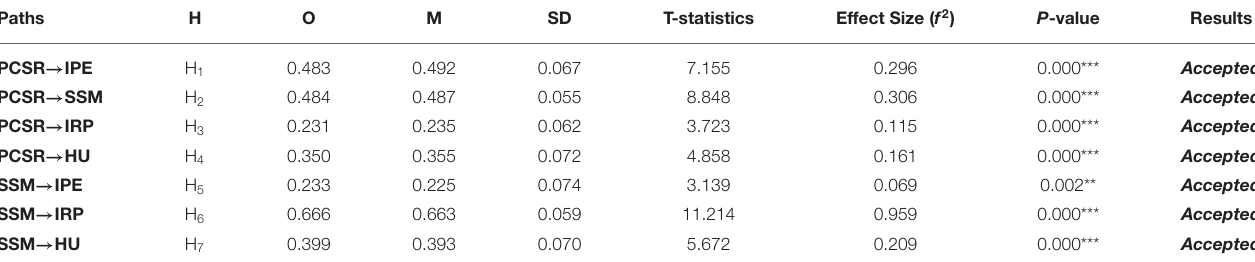
TABLE 5 | Direct effects of the variable.